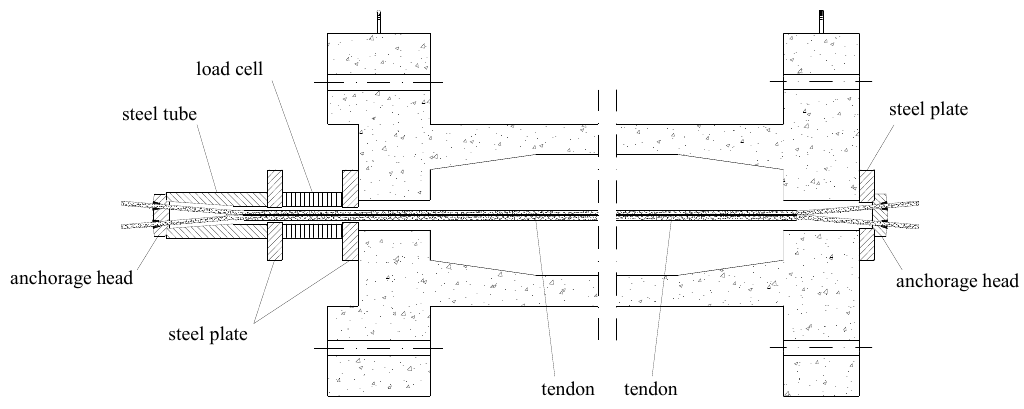
Figure 6. Anchorage zones at both ends of the prestressed beams.